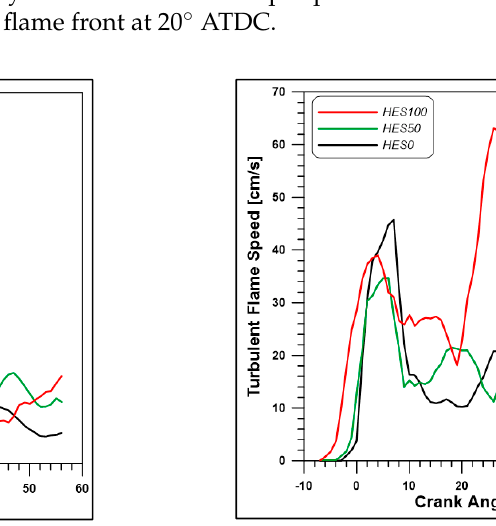
Figure 27. Turbulent kinetic energy.